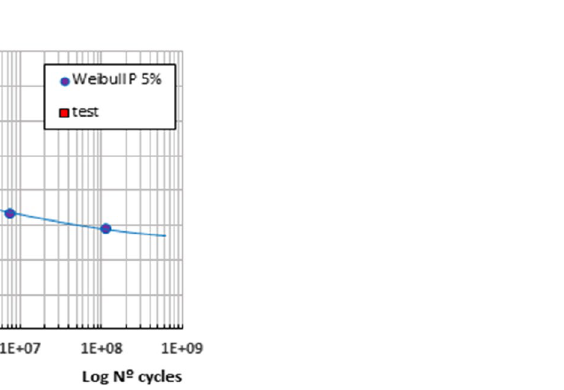
Figure 4. Fatigue initiation curves of material under mode I fracture, for 5% probability of fracture, material under 12 weeks’